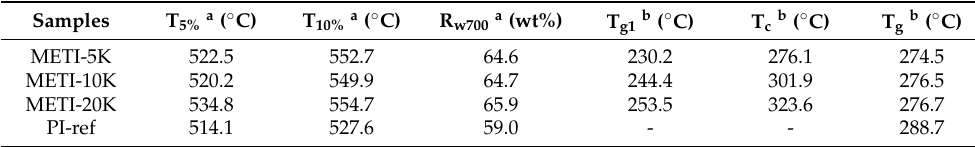
Table 3. Thermal properties of METI